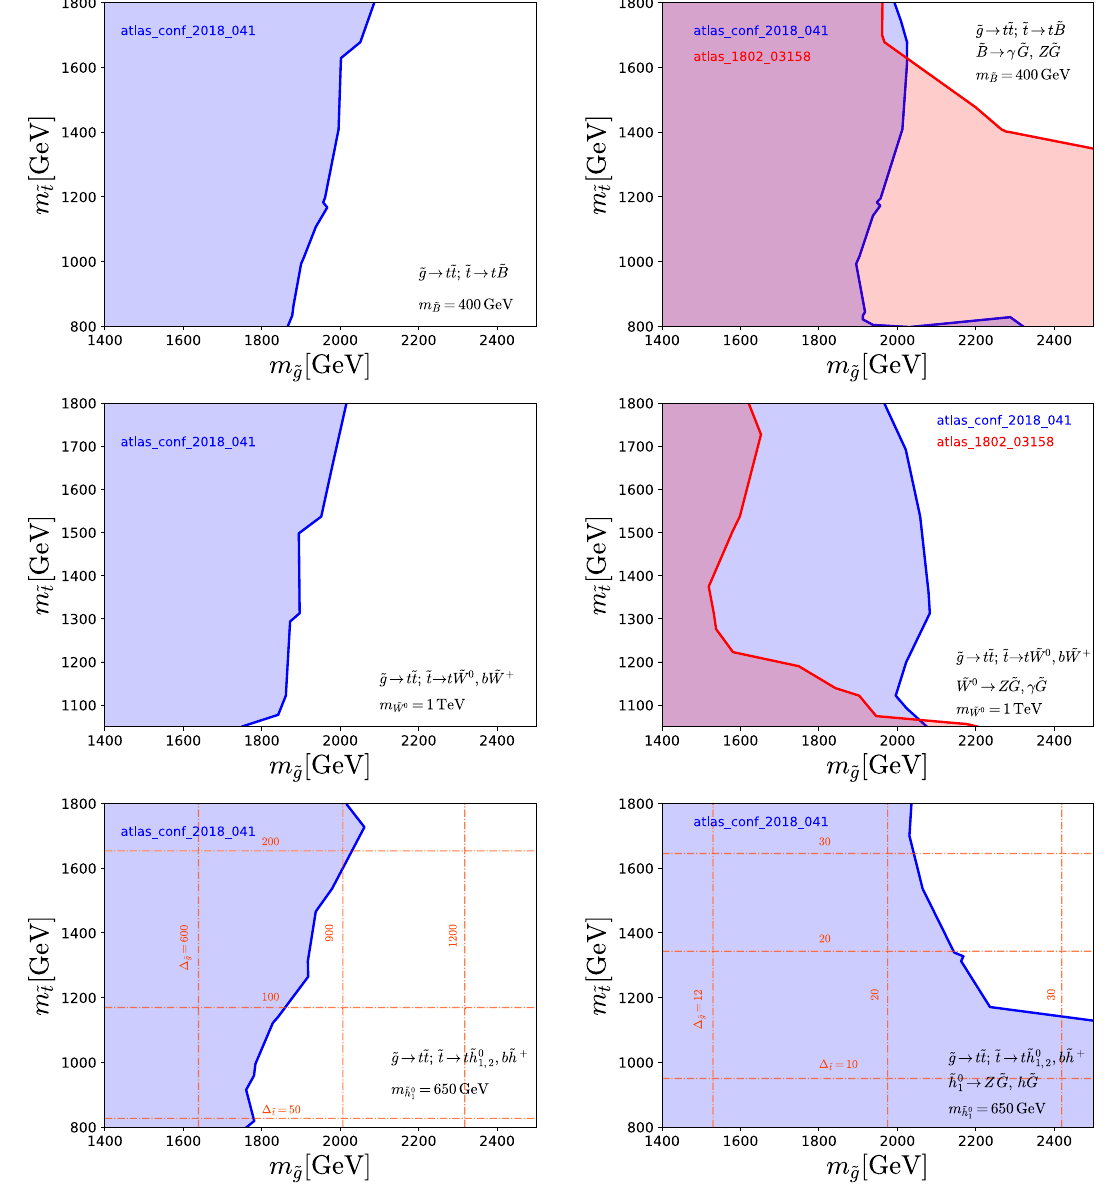
Figure 5 . The exclusion plots in the stop-gluino model, section 4.3. The left column with elec- troweakino as the LSP and the right column with gravitino LSP. From top to bottom: bino, wino and higgsino case. Only the most constraining analyses are shown. For each plot the mass of the (N)LSP was assumed: m = 400 GeV, m = 1 TeV and m = 650 GeV, respectively. In the hig- (cid:31) B (cid:31) h (cid:30) W gsino scenario (bottom) lines of constant fine tuning were imposed: horizontal for top contribution and vertical for gluino contribution; see text for